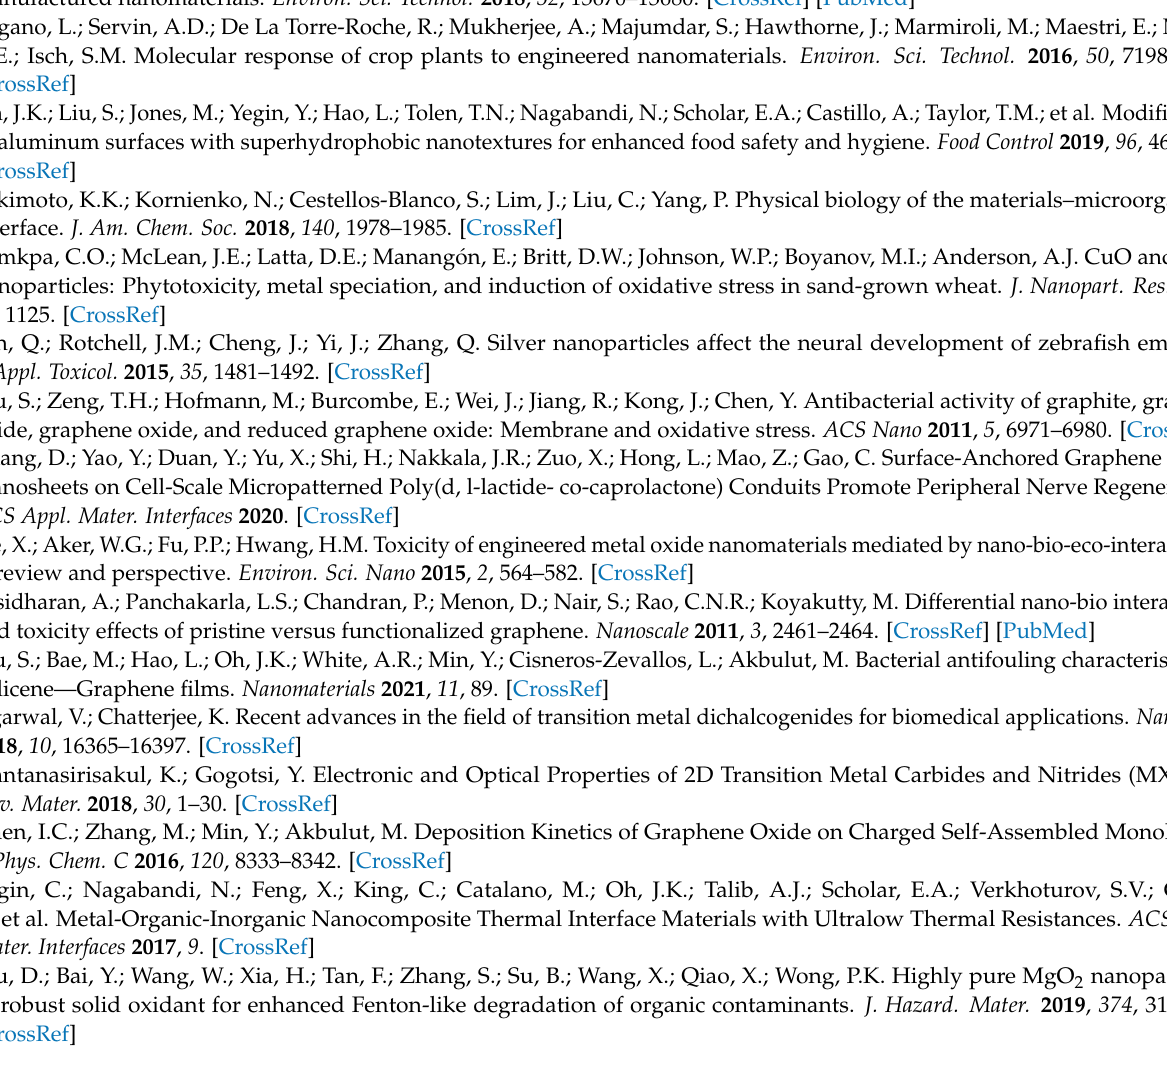
pH plot corresponding to survival results, Table S1: Starting material (MoS 2 ) information, Table S2: Statistical data obtained from survival results, Table S3: Fitting data from the dose–response